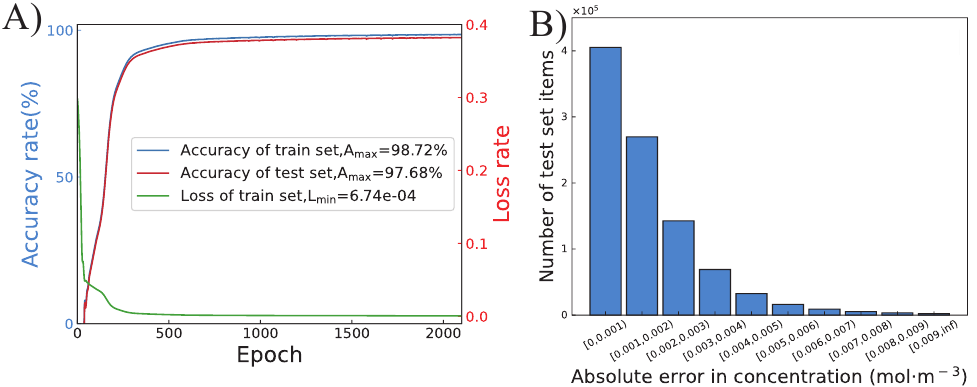
Figure 5. ( A ) The training curve of the proposed ANN during 2000 epochs. ( B ) The histogram of the absolute error in concentration of each data point on two boundaries from test